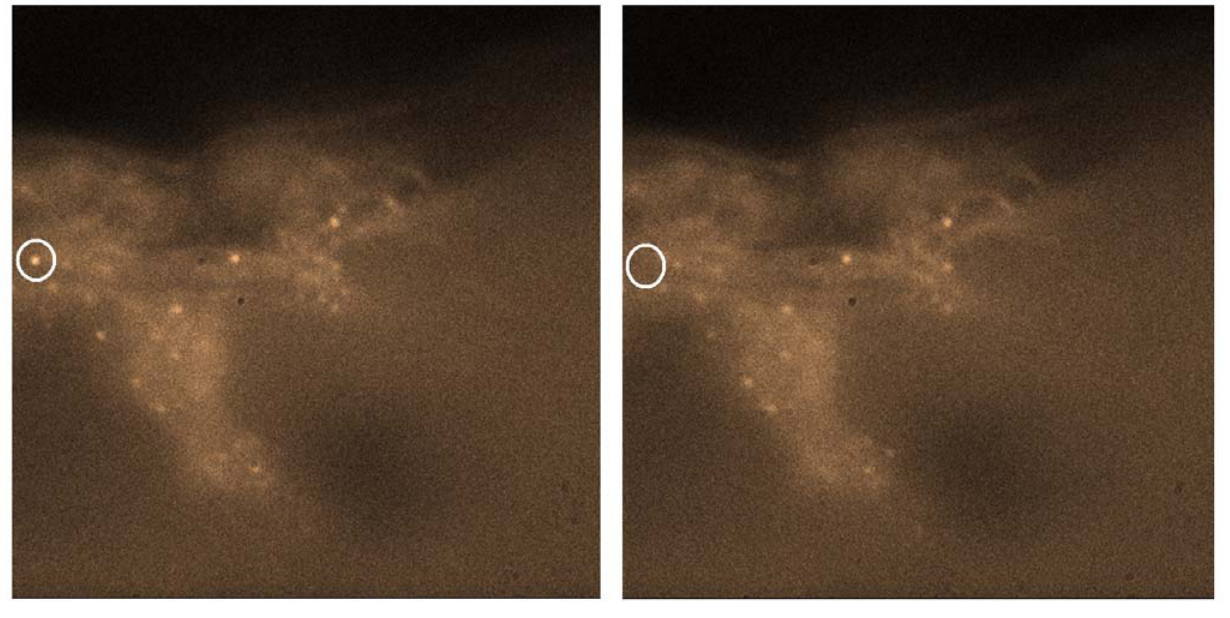
Figure 6. Transverse cuts of porcine skin cells (Top = top of skin) imaged with water soluble quantum dots imaged at different times. Here, single quantum dots can be observed in the cellular structure with one (circled)